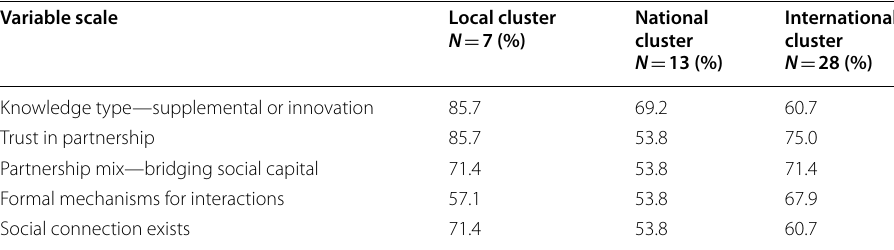
Table 5 Cluster analysis Variable